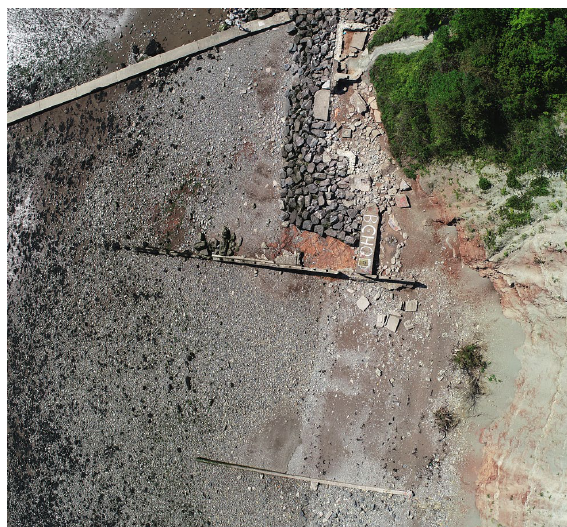
Figure 2 – Changes on the Penarth Beach Regularly Displaces the Beach Materials